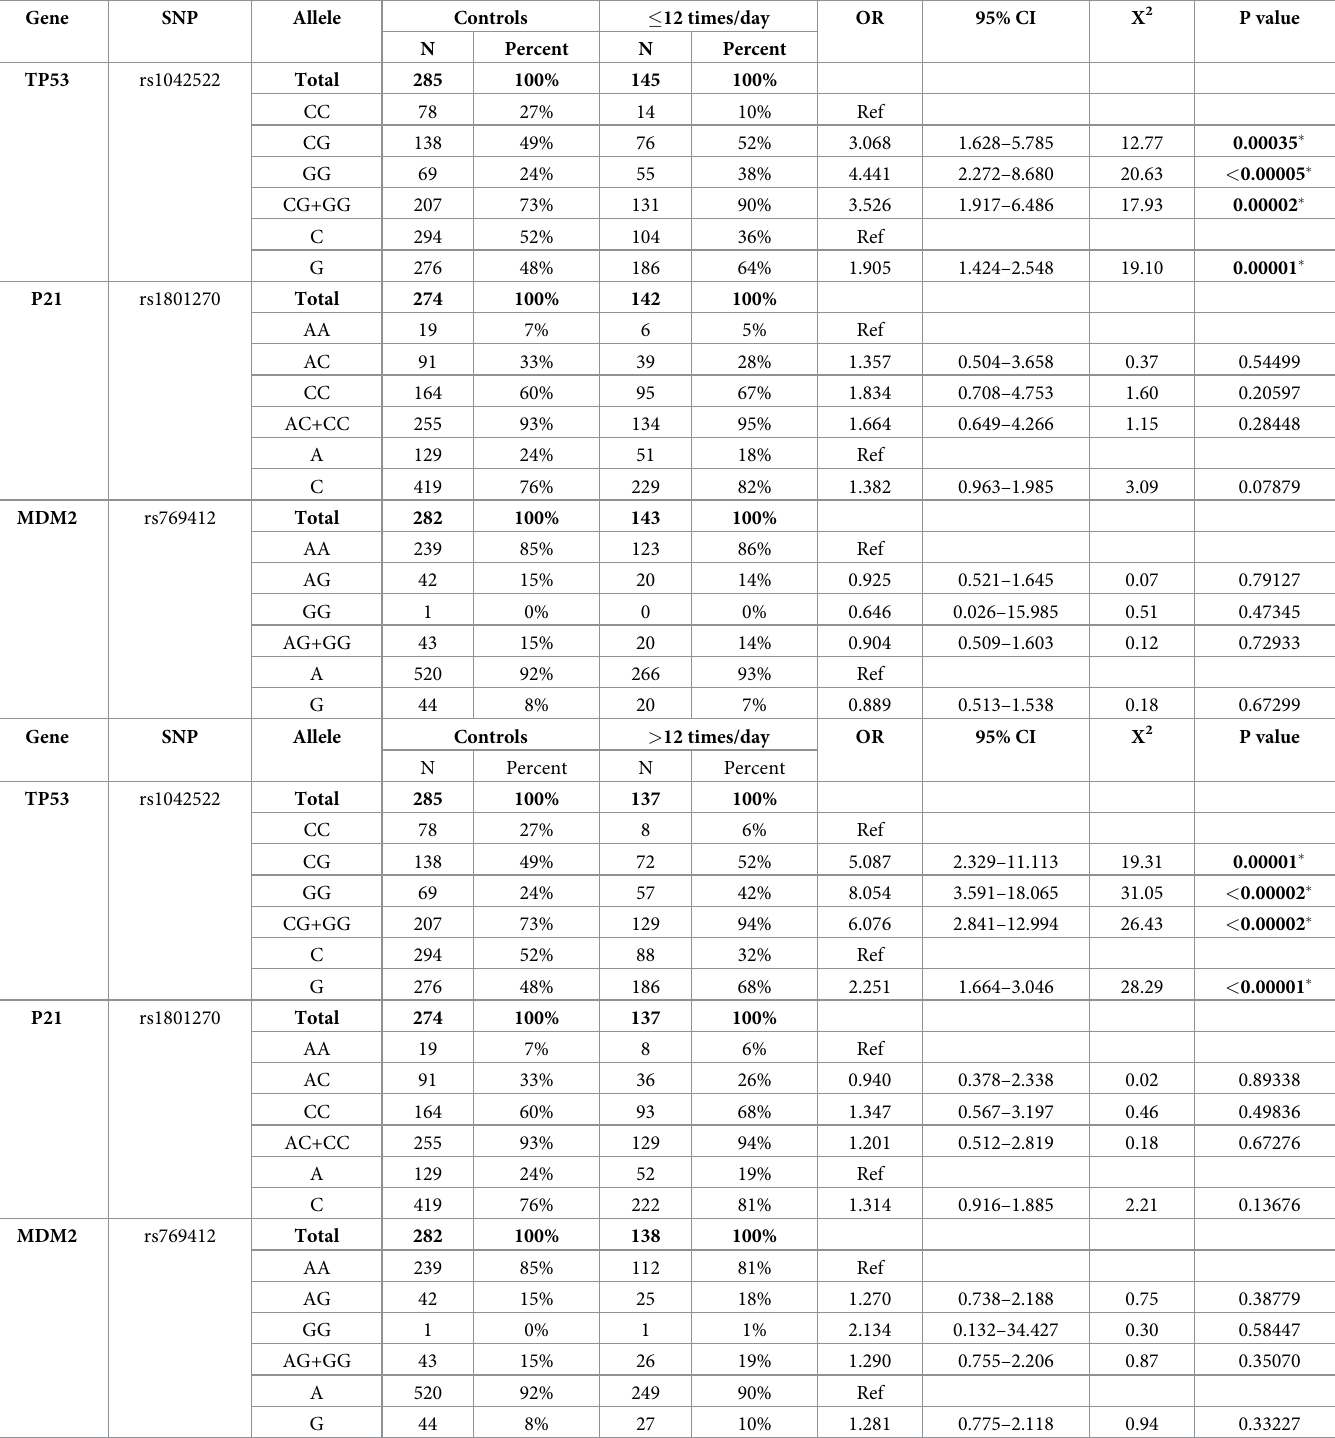
Table 5. Comparison of genotype frequencies of P53, P21, and MDM2 gene polymorphisms in smokers smoking � 12 times/day and > 12 times/day. Gene SNP Allele TP53